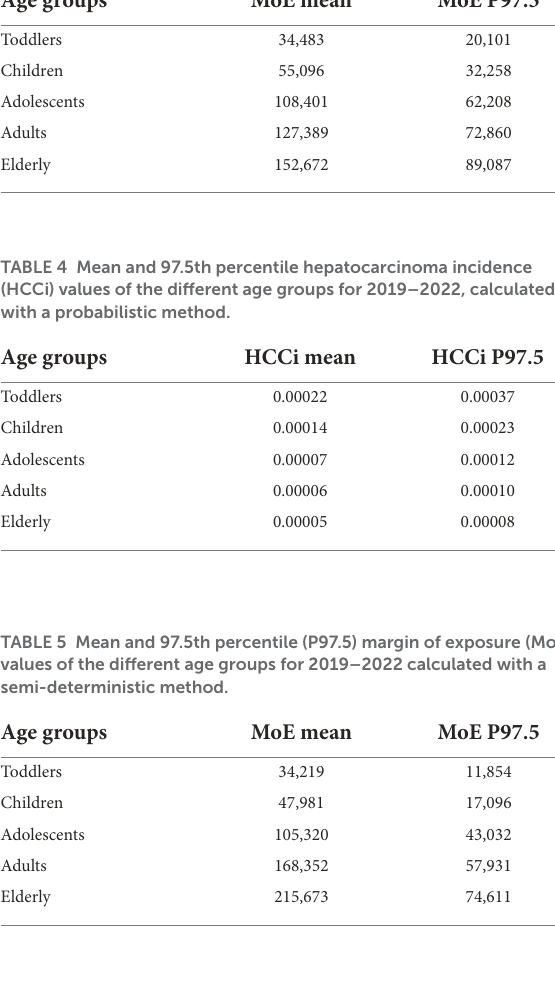
TABLE 6 Mean and 97.5th percentile (P97.5) hazard index (HI) values of the different age groups for 2019–2022 calculated with a semi- deterministic method.